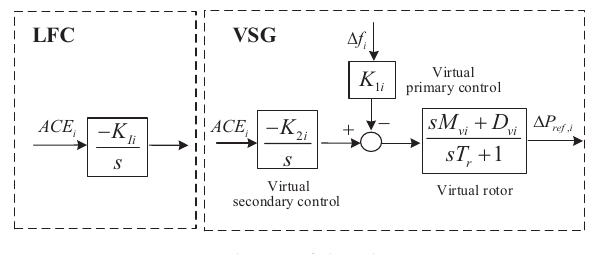
Figure 2. LFC-VSG scheme of the i th area power system. Table 1. Definition of the i th area power system